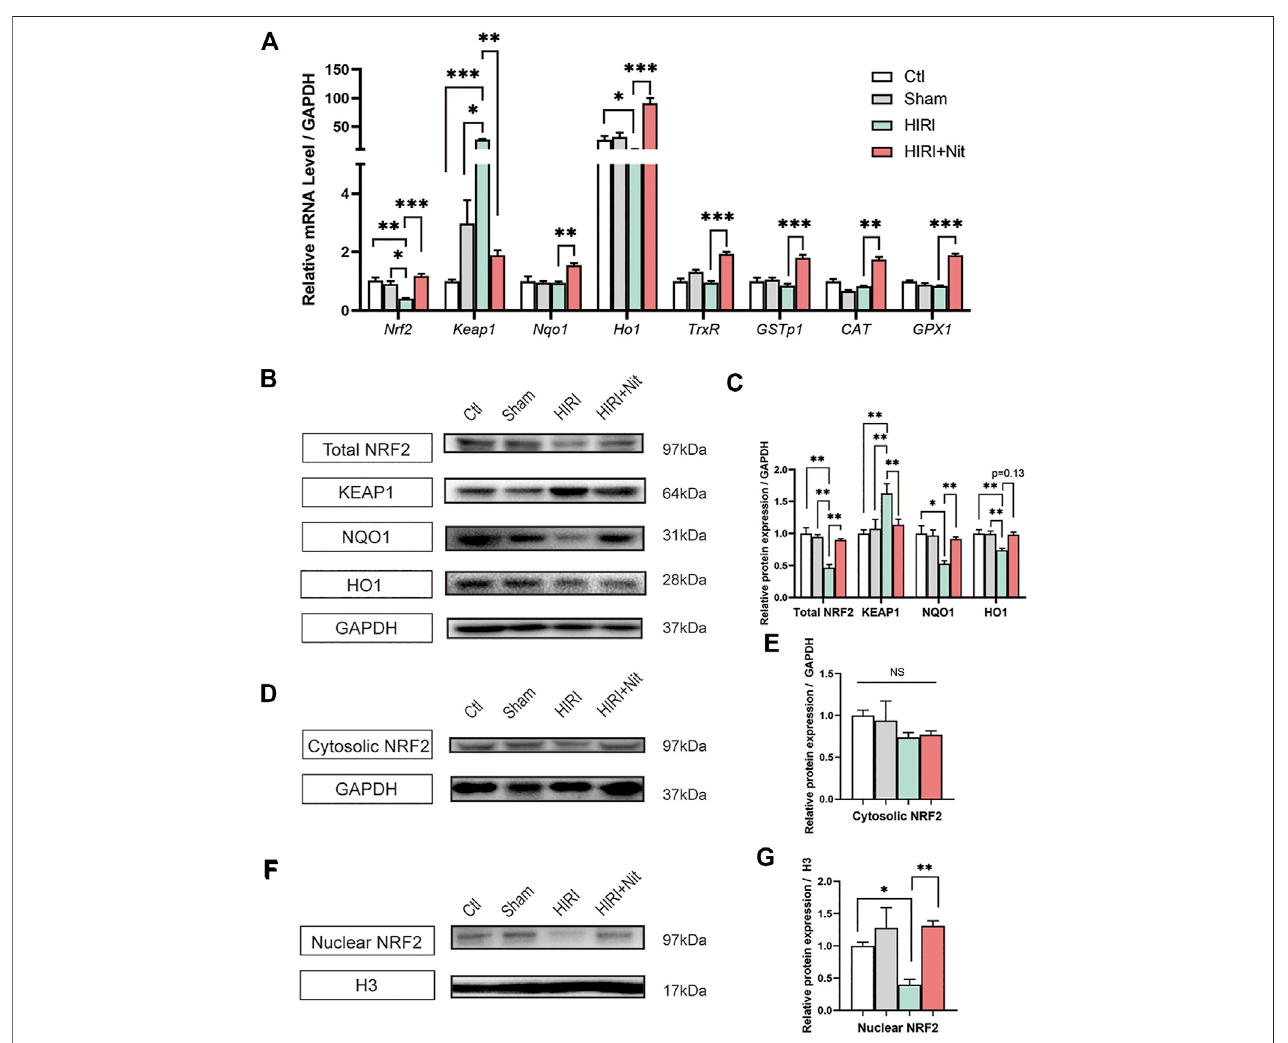
FIGURE 4 | Effects of nitrate pretreatment on NRF2 activation in ischemia-induced mice. (A) Relative mRNA level of Nrf2, Keap1, Nqo1, Ho1, TrxR, GSTp1, CAT, GPX1 . (B) Westernblot analysis oftotal NRF2, KEAP1, NQO1, HO1and (C) statistical analyses. (D) Western blot analysisofcytosolic NRF2 and (E) statistical analyses. (F) Western blot analysis of nuclear NRF2 and (G) statistical analyses. Data are expressed as mean ± SEM, *p ＜ 0.05, **p ＜ 0.01, ***p ＜ 0.001, and NS denotes no signi fi cance .